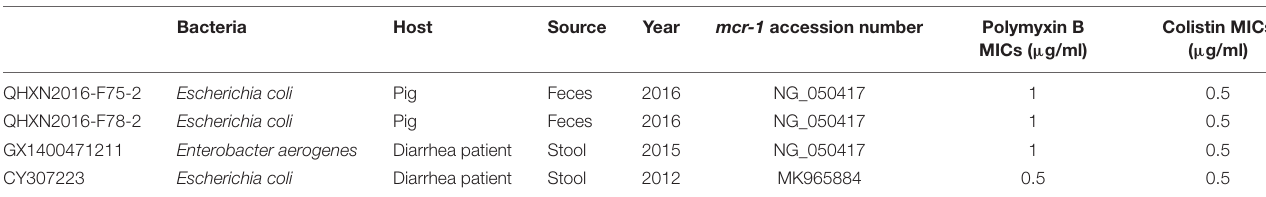
FIGURE 2 | The nucleotide differences, amino acid differences and information of mcr-1 positive strains in this study *NA: not assigned by NCBI. **R: resistant, S:sensitive. TABLE 4 | Strain information and MIC values of polymyxins sensitive